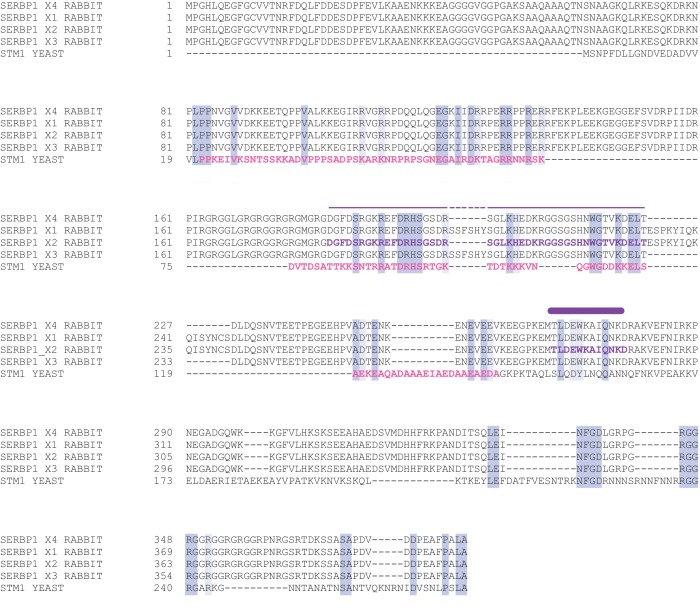
Sequence conservation of Stm1 and SERBP1.Sequence alignment of four isoforms of rabbit SERBP1 and yeast Stm1, with highly conserved residues highlighted in blue. The segments of SERBP1 isoform two modeled from this work are shown above the sequence alignment, depicted as secondary structure.